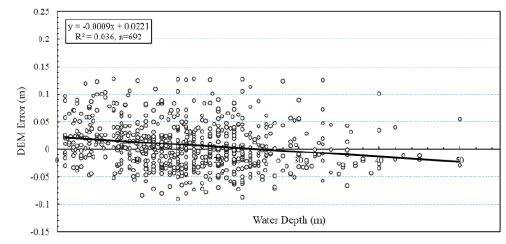
Figure 7. DEM error values against water